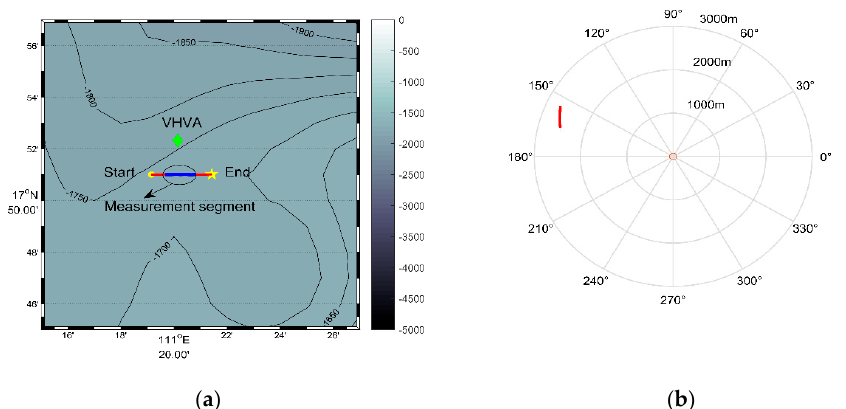
Figure 11. The tilt degree of elevation angle and roll angle during the 100 s processing time.